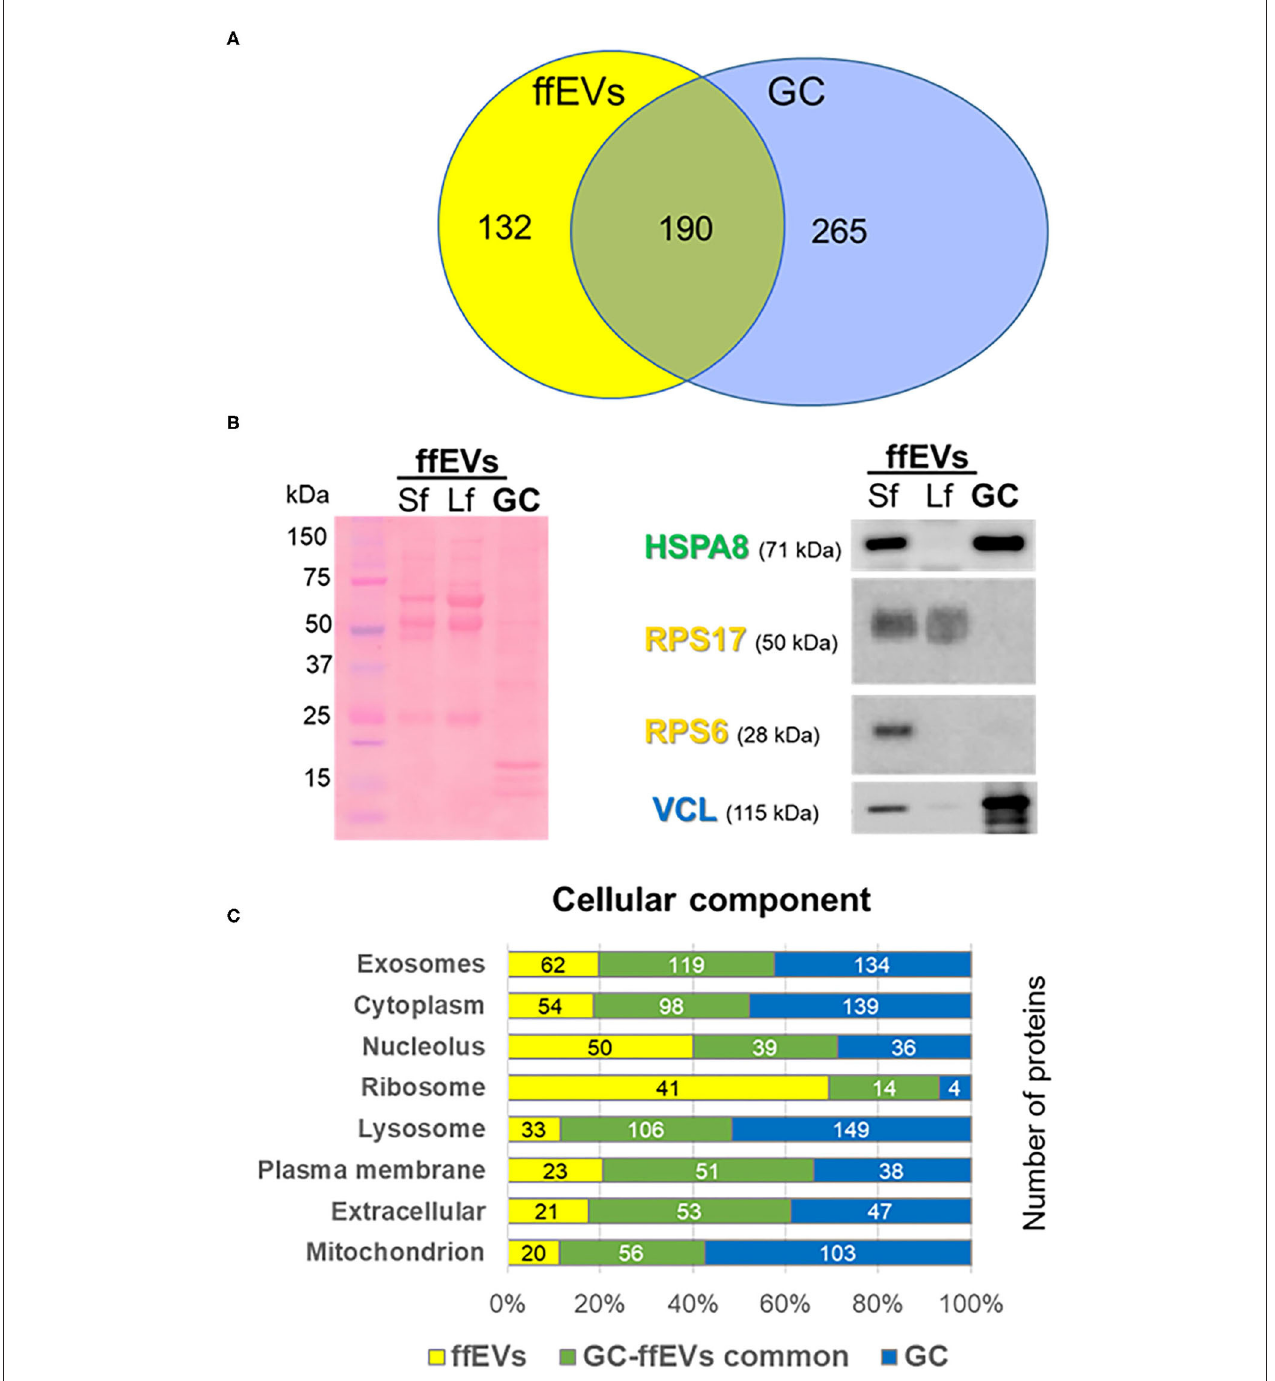
FIGURE 3 | Comparative proteomic analysis of exosome-like extracellular vesicles from follicular fluid (ffEVs) and granulosa cells (GC). (A) Venn diagram was used to compare lists of proteins identified in bovine ffEVs and GC. A number of detected proteins and unique protein identifiers are shown. (B) Western blot analysis of proteins identified in ffEV and/or GC. Total levels of proteins within ffEVs of small follicles (Sf, 3–6mm) and large follicles (Lf, > 10mm) as well as GC were tested via immunoblot using anti-HSPA8 (identified in EV/GC), anti-VCL (identified in GC), anti-RPS6, and anti-RPS17 (identified in ffEVs) antibodies. On the left, a representative picture of a red Ponceau-stained membrane after the electrotransfer of ffEV and GC proteins resolved by SDS-PAGE is shown. (C) Comparative analysis of cellular component GO terms enriched in proteins uniquely identified from ffEVs (ffEVs, yellow color bars), unique to GC (GC, blue color bars), or common to both ffEVs and GC (common ffEV-GC, green color bars). (C) Comparative analysis of biological pathways GO terms associated with proteins of ffEVs, EVs and GC, and GC alone.